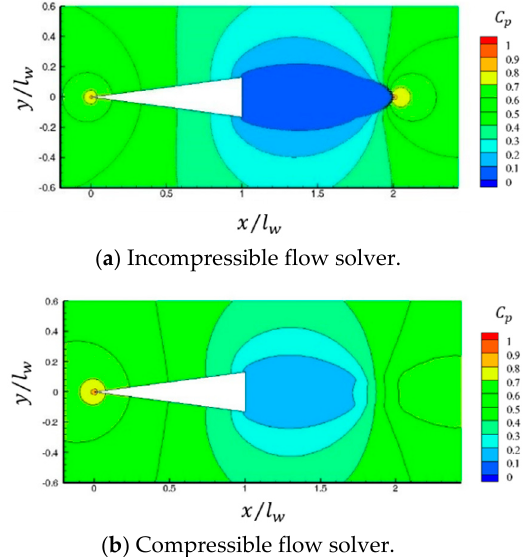
Figure 11. Pressure coefficient contours around wedge at σ = 0.4.